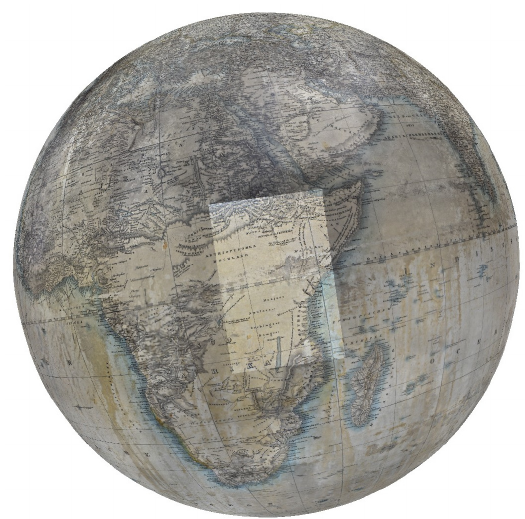
Figure 4. Dividing the whole globe into segments. Source: author, Agisoft.